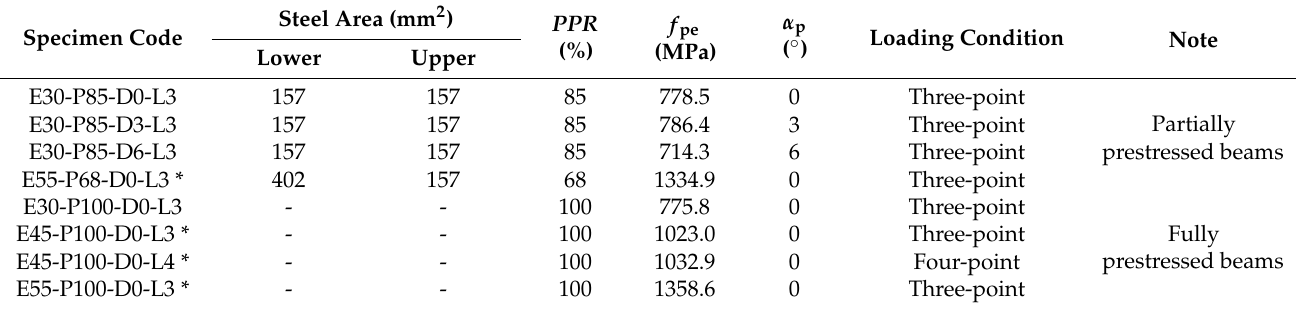
Table 1. Details of